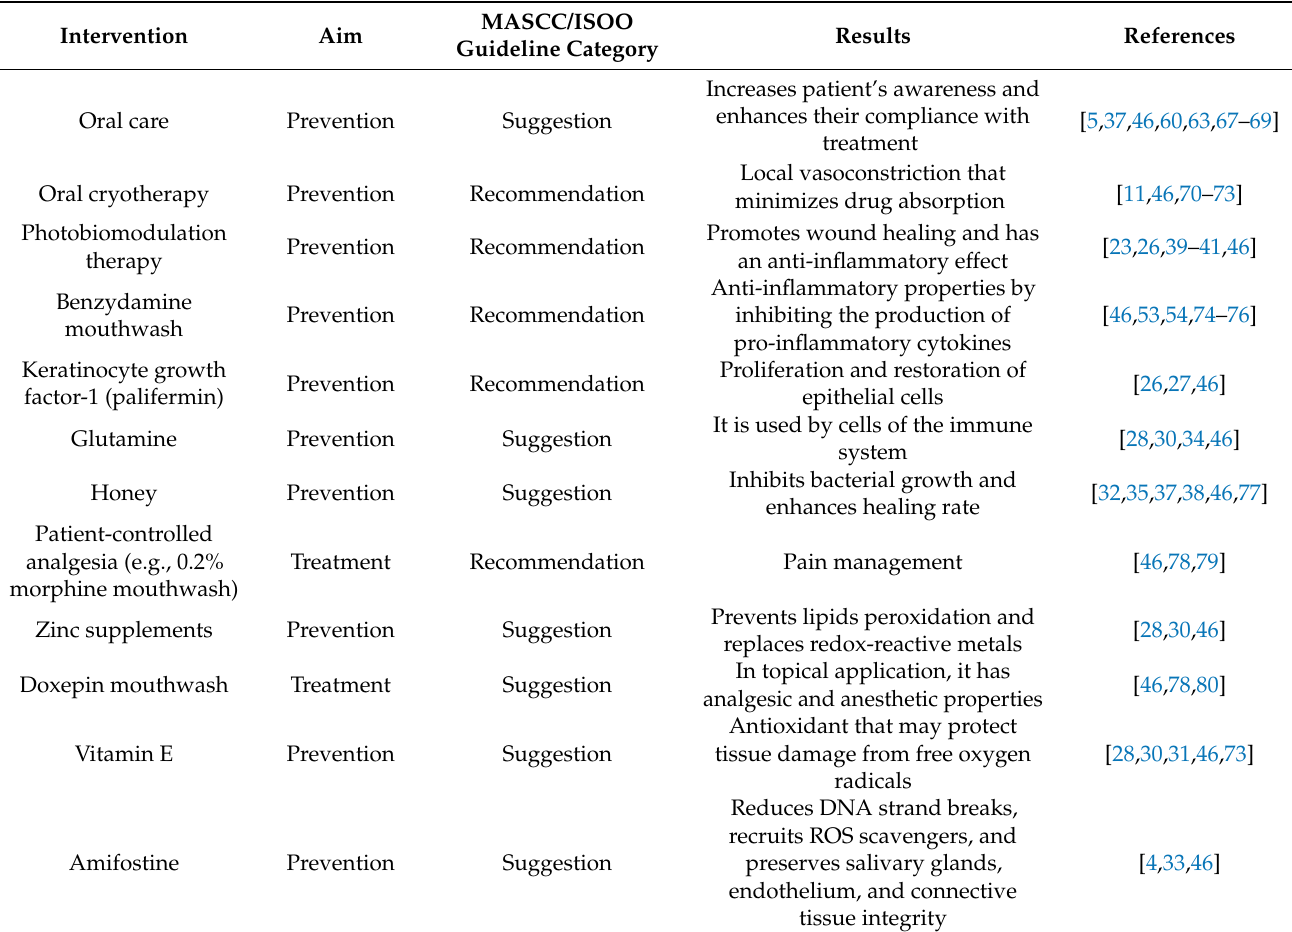
Table 3. Management of Oral Mucositis Guidelines created by the Multinational Association for Supportive Care in Cancer and the International Society of Oral